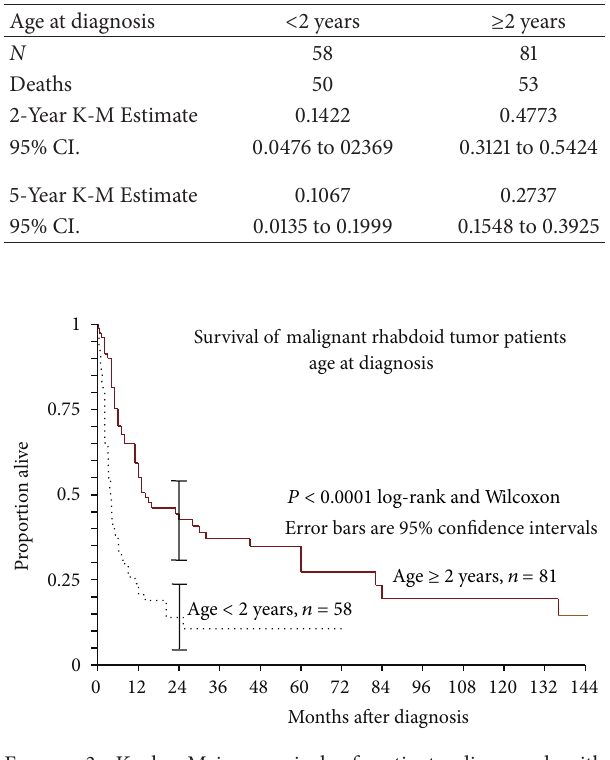
Figure 3: Kaplan-Meier survival of patients diagnosed with extrarenal extra-CNS malignant rhabdoid tumor with four-year survivalcomparingpatientslessthantwoyearsoldversusolderthan two at diagnosis was 11% versus 35%, respectively ( 𝑃 = 0.0001 ).